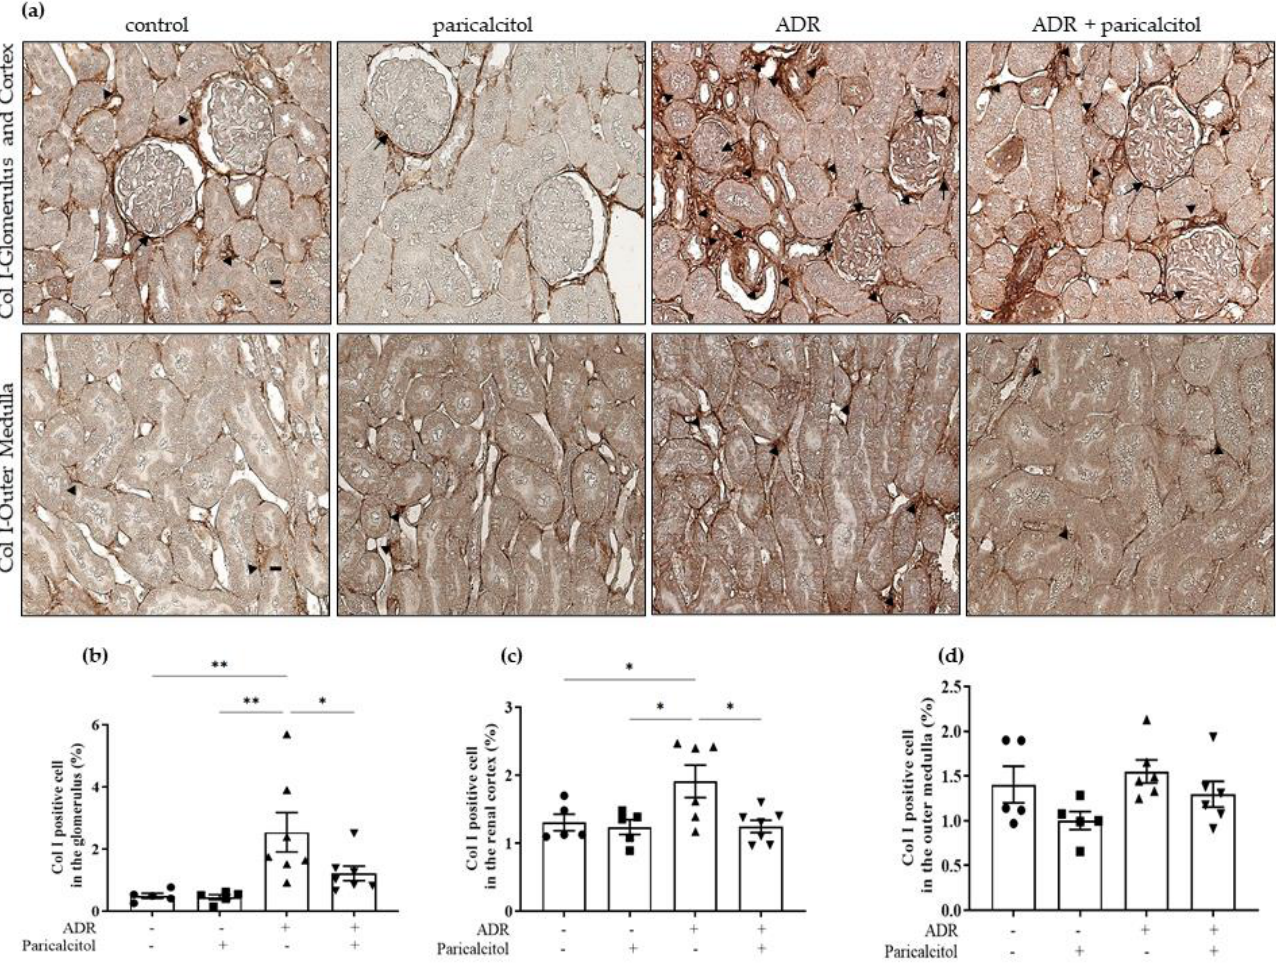
Figure 8 . ( a ). The immunolocalization of Col I in all renal compartments. The arrows indicate the Col I-positive expression in the glomerulus. The arrowheads indicate the Col I-positive expression in the tubulointerstitial compartments. ( b ). Percentual of Col I-positive in the glomerulus. ( c ). Percentual of Col I-positive in the renal cortex. ( d ). Percentual of Col I-positive in the outer medulla. Immunohistochemical data are expressed as the mean ± SEM. Scale bar = 20 µ m. n = 5–7 for each group. Data from the control (dots), paricalcitol (squares), ADR (up triangles), and ADR + paricalcitol (down triangles) groups. * p < 0.05; ** p < 0.01.